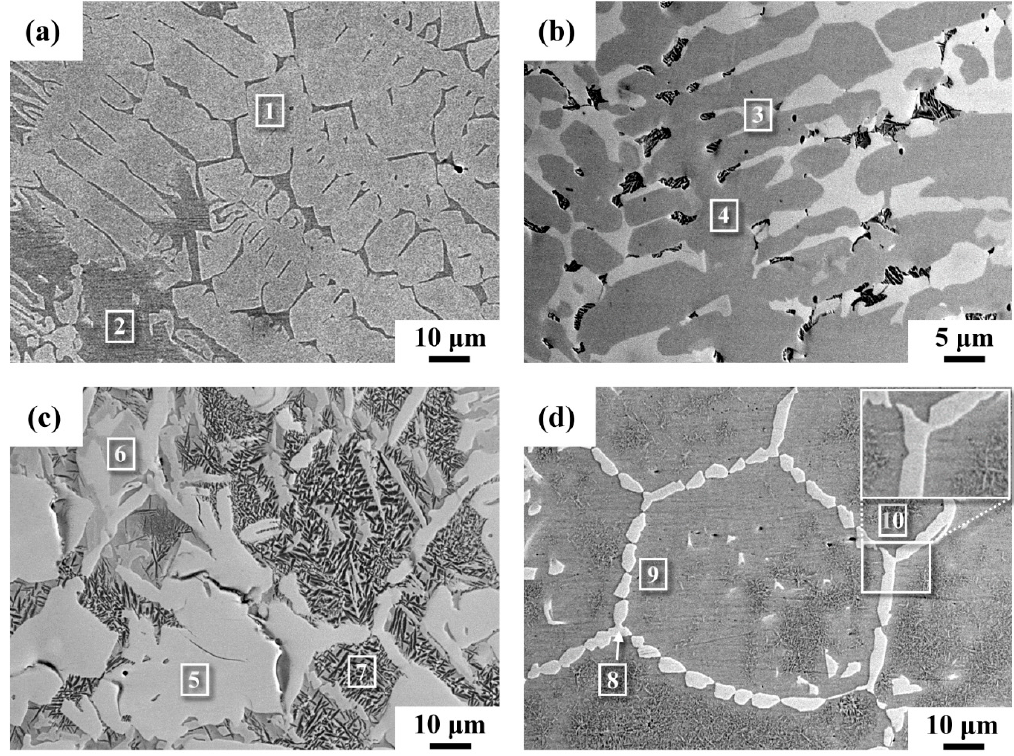
Figure 7. BSE-SEM micrographs of the B3 sample cut parallel to the joint interface, ( a ) the center of the brazed zone, ( b ) the edge of the brazed zone as displayed in Figure 2, ( c ) near the central brazed zone, ( d ) grain boundary liquation zone. Table 2. Chemical compositions in at% of marked sites in Figure 7.